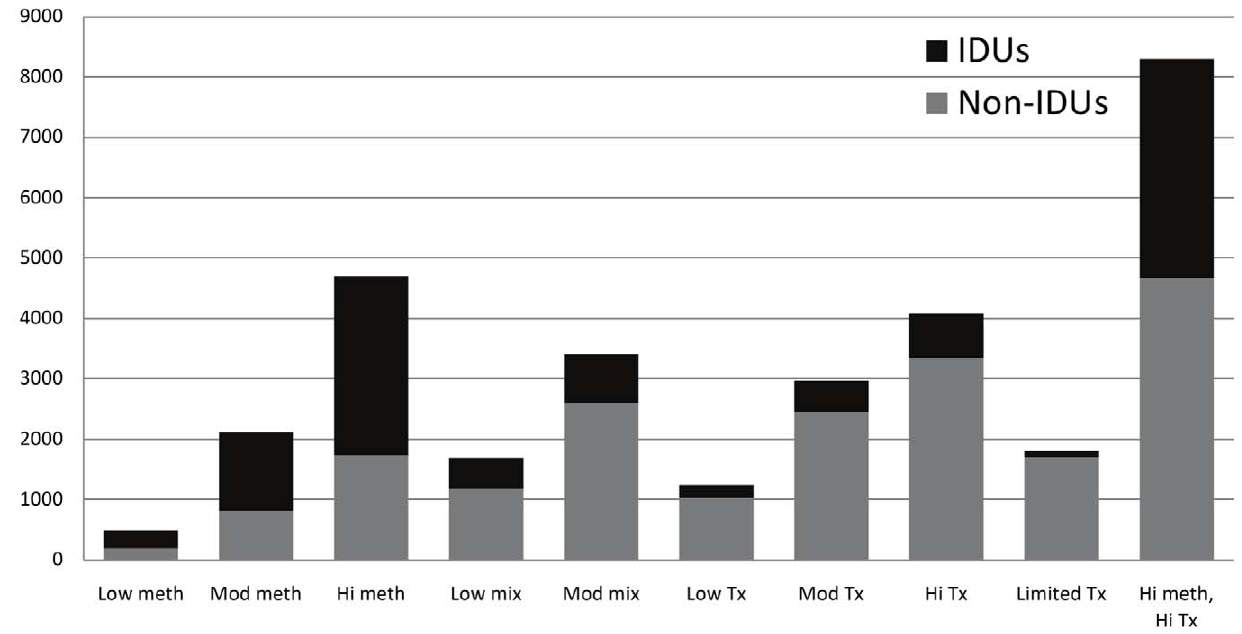
Figure 3. Estimated number of HIV infections averted over 20 y among IDUs and non-IDUs for strategies to expand methadone substitution therapy and ART access in Ukraine. Low meth, 3.1% of IDUs on methadone substitution therapy, ART according to status quo except 25% of eligible IDUs on methadone substitution therapy on ART; Mod meth, 12.5% of IDUs on methadone substitution therapy, ART according to status quo except 25% of eligible IDUs on methadone substitution therapy on ART; Hi meth, 25% of IDUs on methadone substitution therapy, ART according to status quo except 25% of eligible IDUs on methadone substitution therapy on ART; Low mix, 3.1% of IDUs on methadone substitution therapy, 20% of eligible non-IDUs and IDUs not on methadone substitution therapy on ART, 25% of IDUs on methadone substitution therapy on ART; Mod mix, 3.1% of IDUs on methadone substitution therapy, 50% of all eligible patients on ART; Low tx, no methadone substitution therapy slots, 20% of all eligible patients on ART; Mod tx, no methadone substitution therapy slots, 50% of all eligible patients on ART; Hi tx, no methadone substitution therapy slots, 80% of all eligible patients on ART; Limited tx, no methadone substitution therapy slots, 80% of eligible non- IDUs on ART, 10% of eligible IDUs on ART; Hi meth, hi tx, 25% of IDUs on methadone substitution therapy, 80% of all eligible patients on